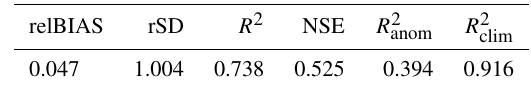
Table 2. Median values of skill scores computed for the large GRDC river